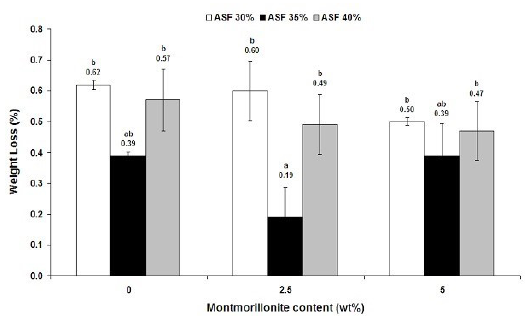
Figure 2. The average and standard errors for the hardness measurements of the composites. Results with different letters are significantly different (MMT: